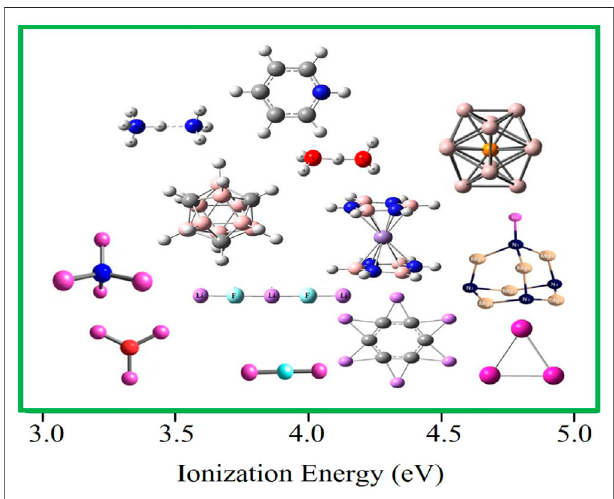
FIGURE 1 | Ionization energy scale of various superalkalis is considered here. The values are taken from Refs. 17 – 22, 25, and 35.